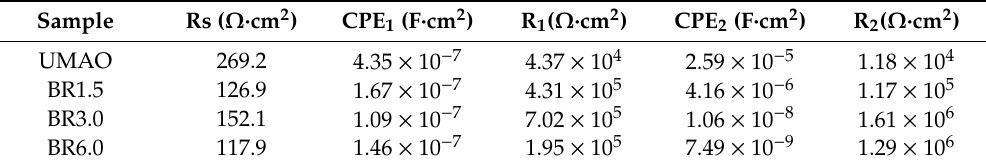
Figure 8. Nyquist, Bode diagrams and equivalent circuits of different coatings: ( a ) Nyquist; ( b ) and ( c ) Bode plots; ( d ) equivalent circuit (CPE, capacitance of coating). Table 5. Values of the equivalent circuit parameters for the various coatings extracted from the electrochemical impedance spectroscopy (EIS) plots. CPE, capacitance of